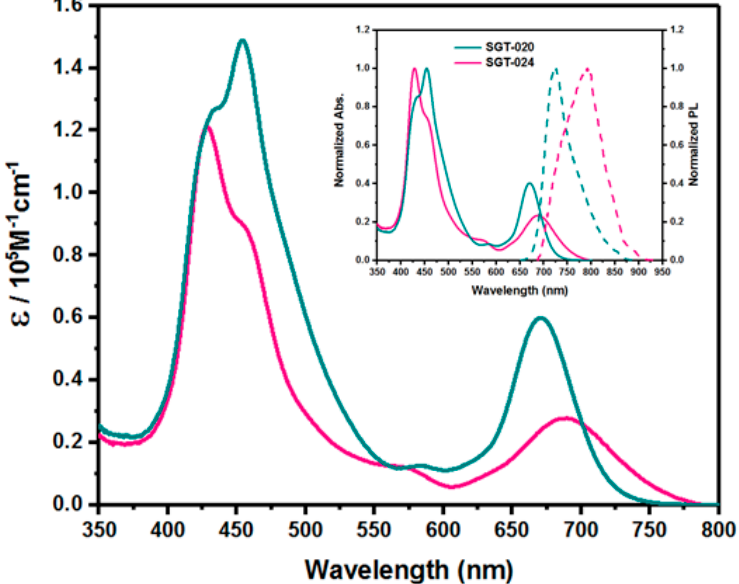
Figure 1. Absorption spectra and emission spectra of SGT-020 and SGT-024 in THF.